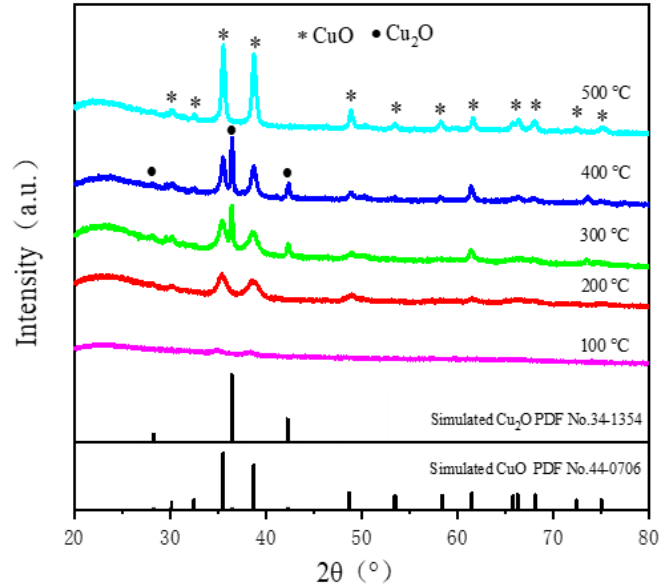
Figure 3. XRD patterns of 20%Cu-A-BM samples pretreated at different temperatures.